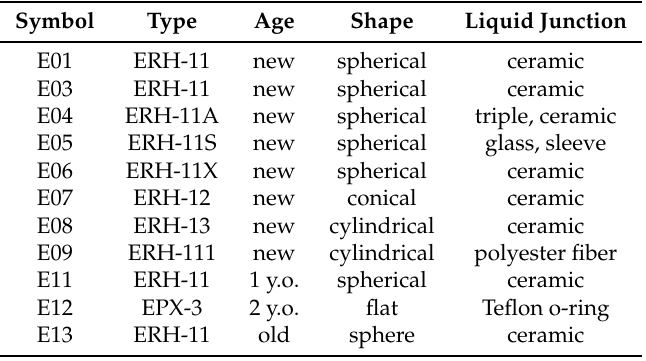
Table 1. Electrodes used in investigations. All electrodes are of 12-mm